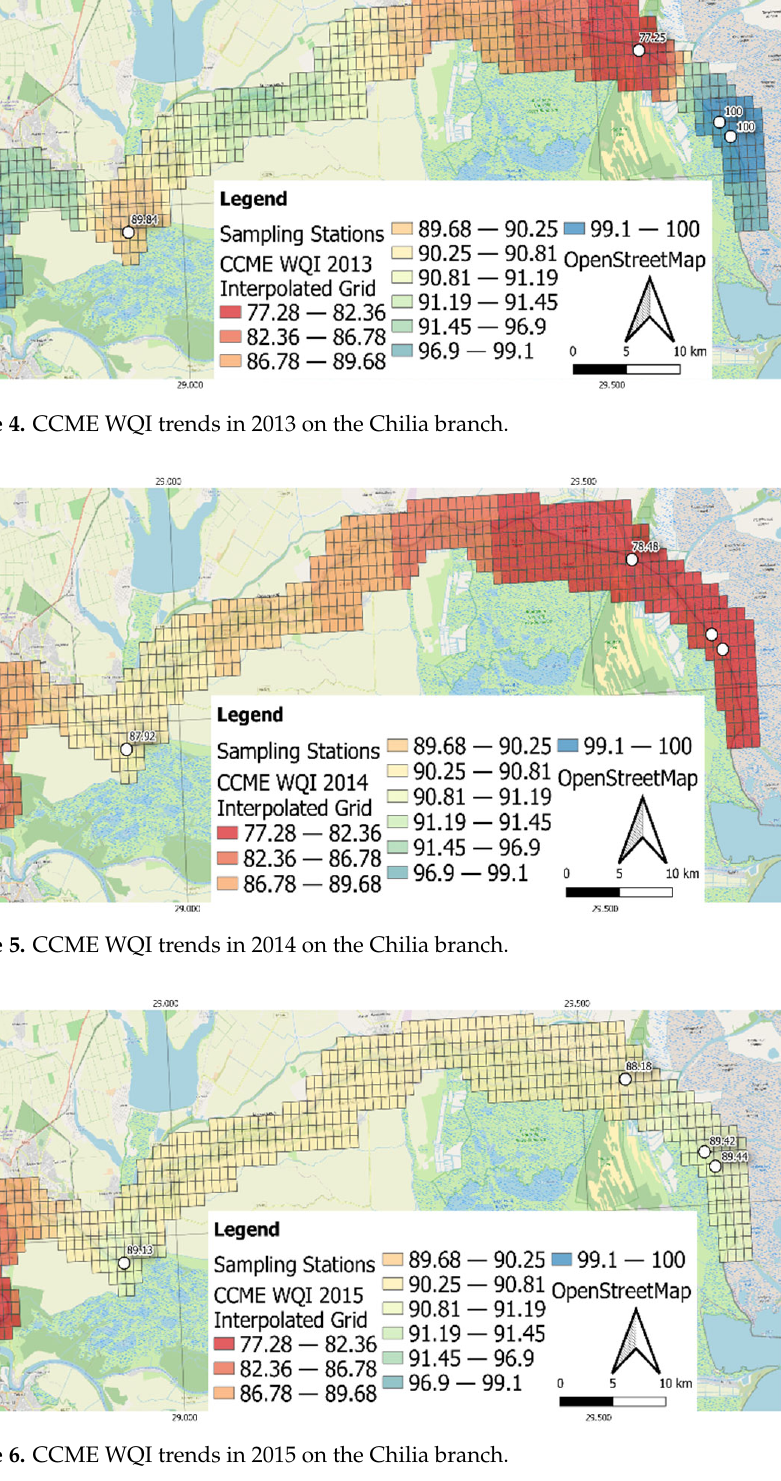
Figure 7. CCME WQI trends in 2016 on the Chilia branch. Figure 8. CCME WQI trends in 2017 on the Chilia branch. Figure 9. CCME WQI trends in 2018 on the Chilia branch.